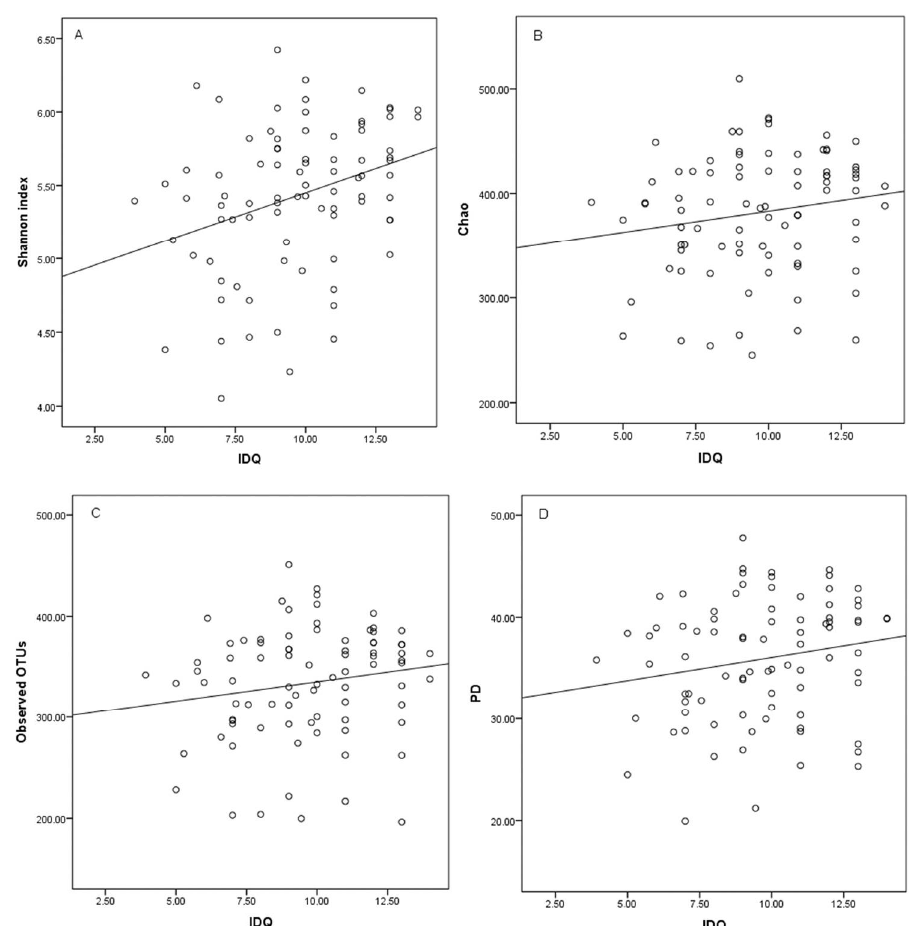
Figure 1. Correlations between index of diet quality (IDQ) score and gut microbiota diversity indexes: ( a ) Shannon index, ( b ) Chao index, ( c ) observed operational taxonomic units (OTUs), ( d ) phylogenetic diversity (PD) ( n = 84).